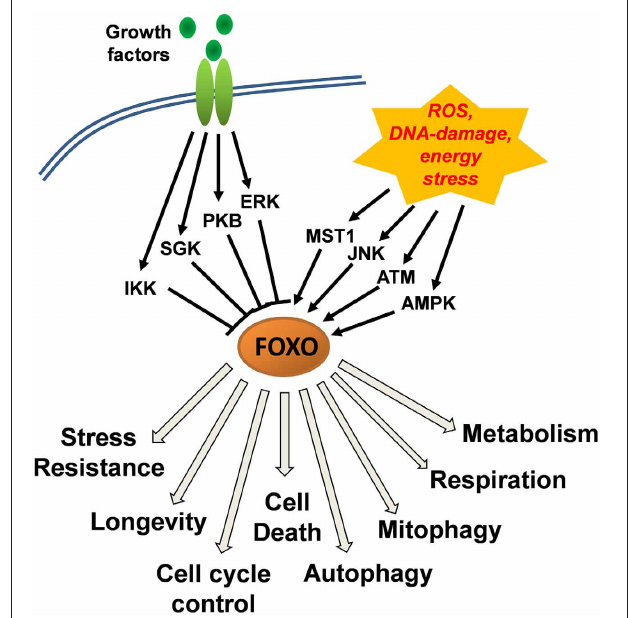
FIGURE 1 | Control of FOXO function downstream of growth-factor and stress-induced kinase signaling cascades. Growth factor signaling via protein kinase B (PKB), serum- and glucocorticoid-induced kinase (SGK), IkB-kinase (IKK), and extracellular-signal regulated kinase (ERK) causes inactivation of FOXO transcription factors and their export from the nucleus. Jun-N-terminal kinase (JNK) and mammalian STE20-like protein kinase 1 (MST1) that are activated upon cellular stress, induce the nuclear accumulation of FOXOs. A main trigger of JNK activation is accumulation of cellular reactive oxygen species (ROS) which together with DNA-damage also activate ataxia telangiectasia mutated (ATM) kinase and induce the interaction between ATM and FOXO and its nuclear accumulation. AMP-activated kinase (AMPK) functions as a cellular energy sensor that increases the activity of nuclear FOXO factors. AMPK thereby acts in concert with either low growth factor availability or high cellular stress and further steers FOXO target